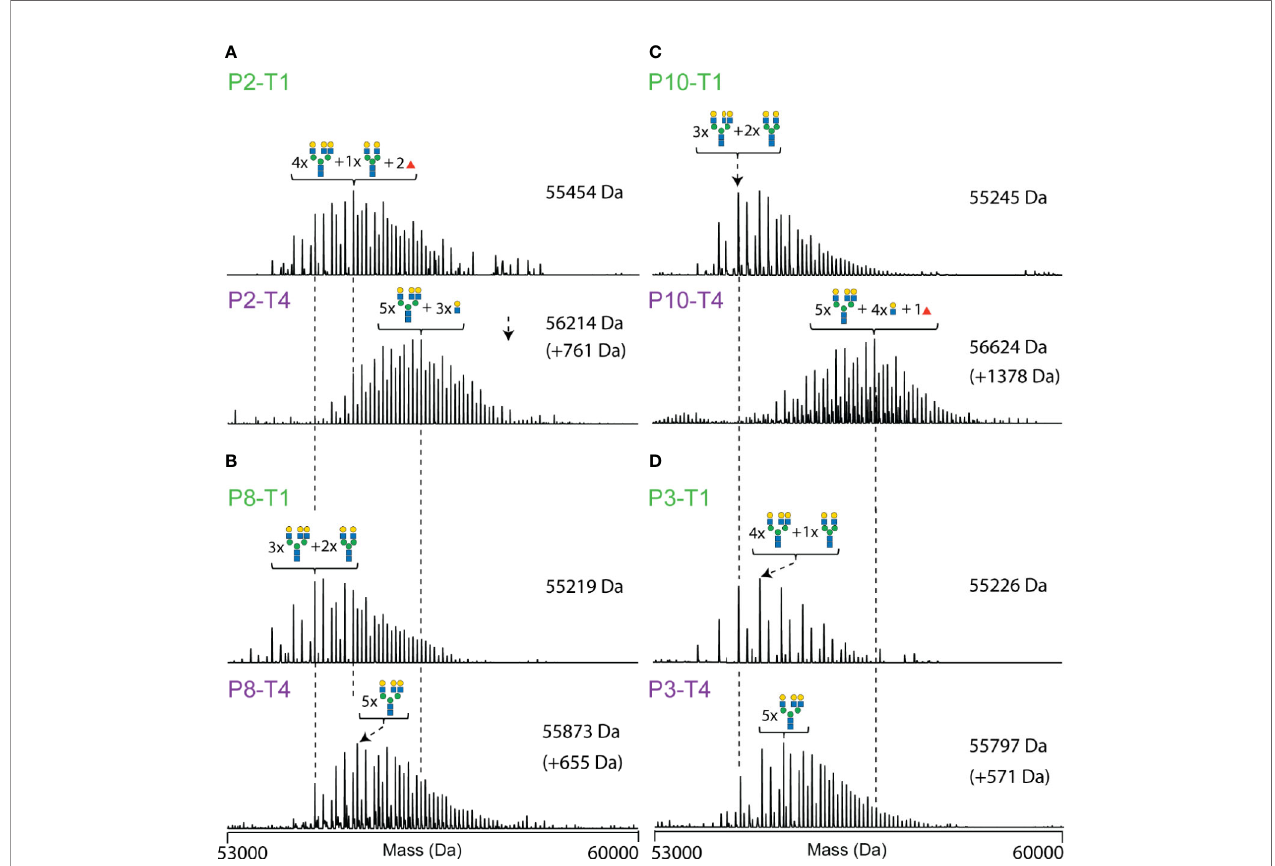
FIGURE 6 | Deconvoluted native mass spectra of desialylated AACT, illustrating unique differences in between patients and the extensive glycoproteoform remodeling observed between T1 and T4. Spectra are shown for four patients, each at two-time points (T1 at the top and T4 at the bottom). Data for patient P2 are shown in (A) , P8 in (B) , P10 in (C) , and P3 in (D) . The most abundant peak in each spectrum is annotated with a likely glycan composition. As a visual guide, dashed lines connect peaks of the same